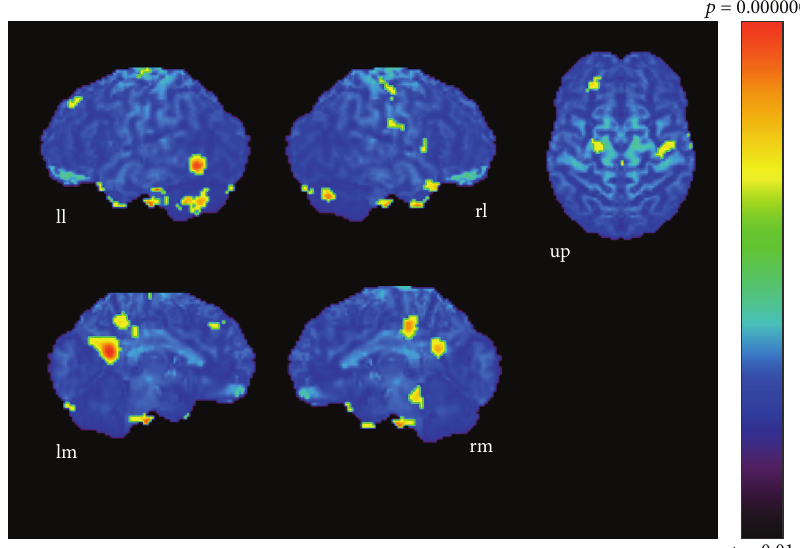
Figure 5: Complex-simple condition ( 𝑝 < 0.001 ). ll: lateral surface of left hemisphere; lm: medial surface of left hemisphere; rl: lateral surface of right hemisphere; rm: medial surface of right hemisphere; up: upper surface.